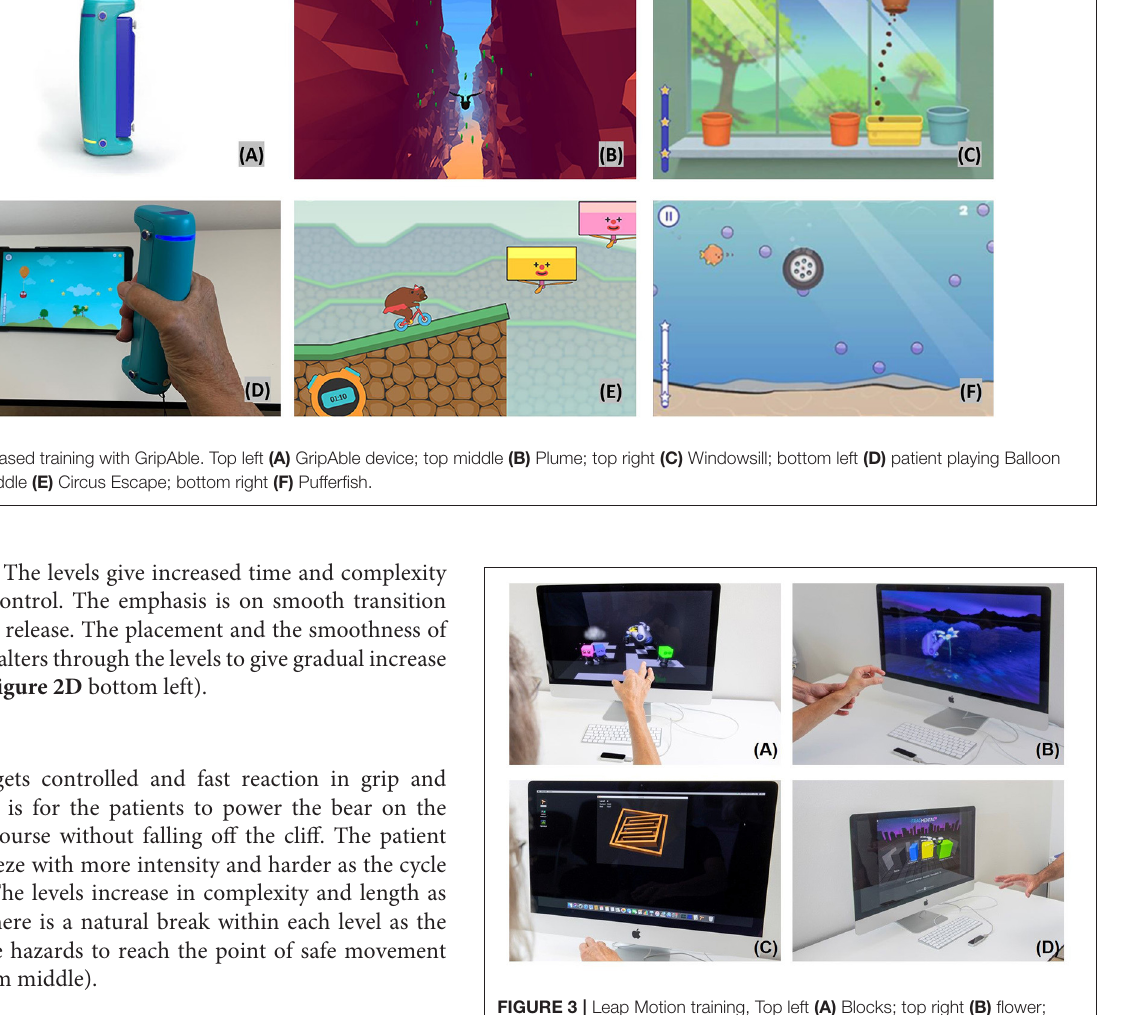
FIGURE 3 | Leap Motion training, Top left (A) Blocks; top right (B) flower; bottom left (C) Tilt Your Ball; bottom right (D) Fragmented 3D.